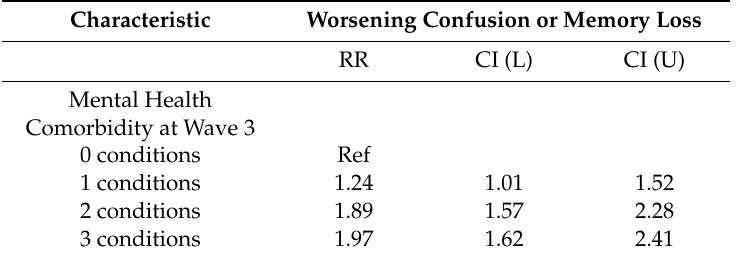
Table 3. Risk of worsening Confusion or Memory Loss (CML) based on mental health comorbidity among those who reported any CML 1